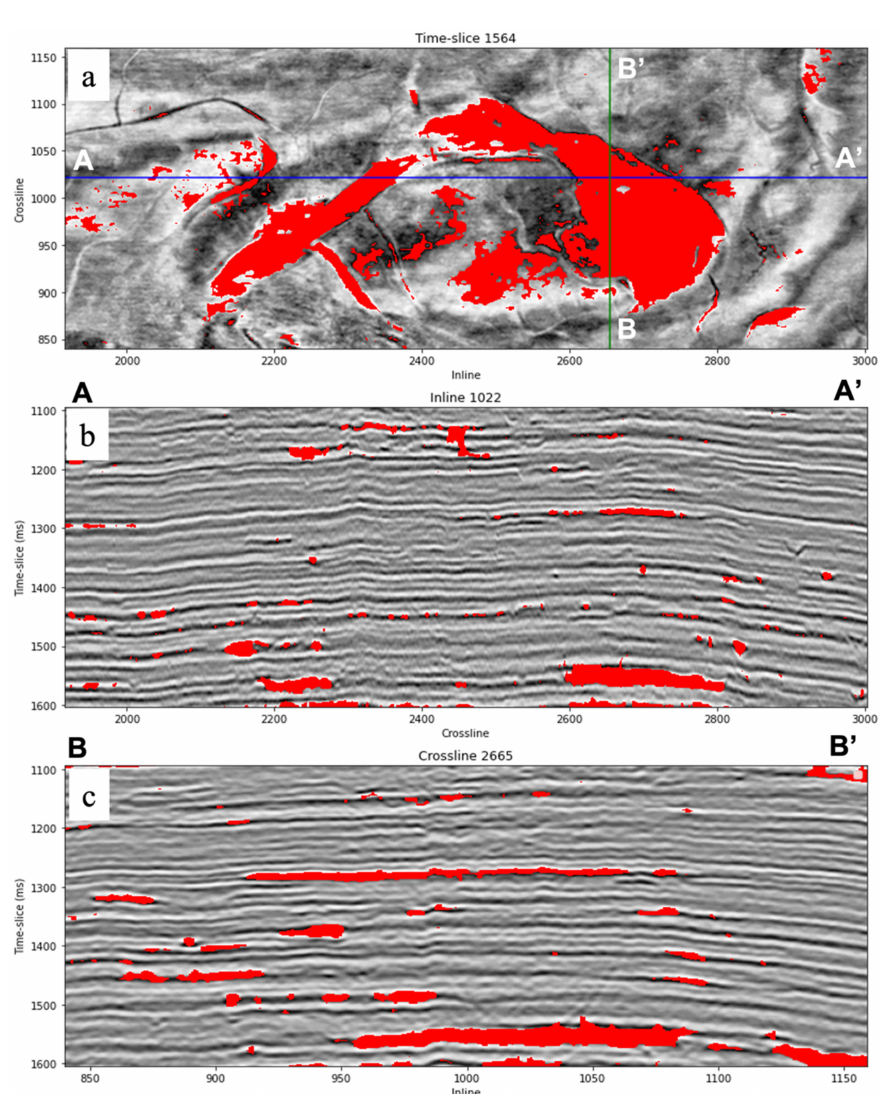
Figure 25. The predicted result of channel features on ( a ) time-slice, ( b ) inline, and ( c ) crossline seismic section.